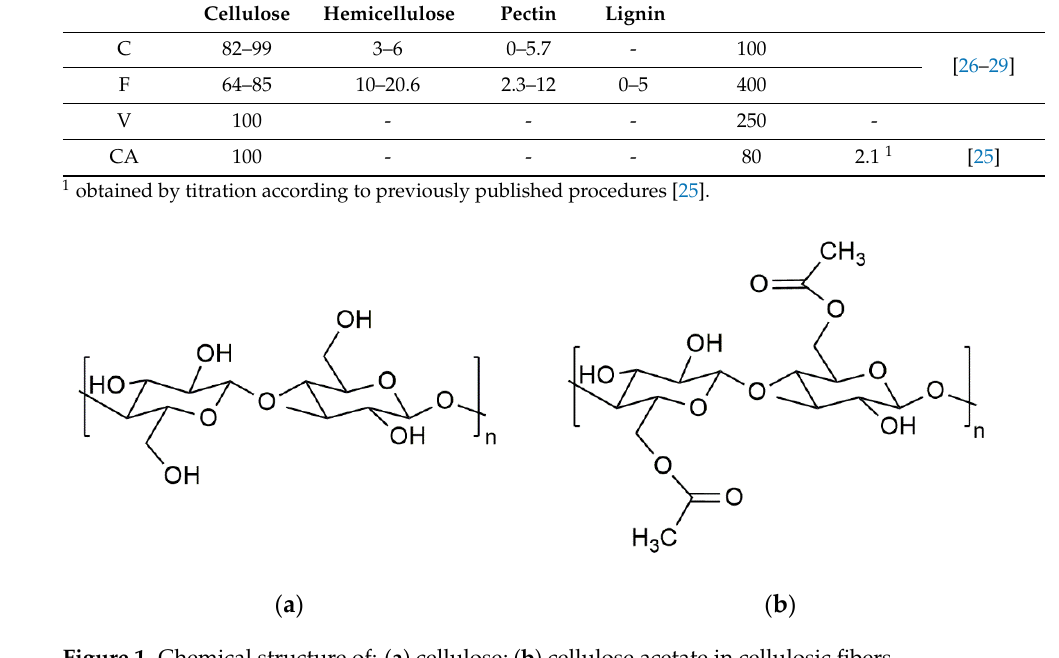
Figure 1. Chemical structure of: ( a ) cellulose; ( b ) cellulose acetate in cellulosic fibers.